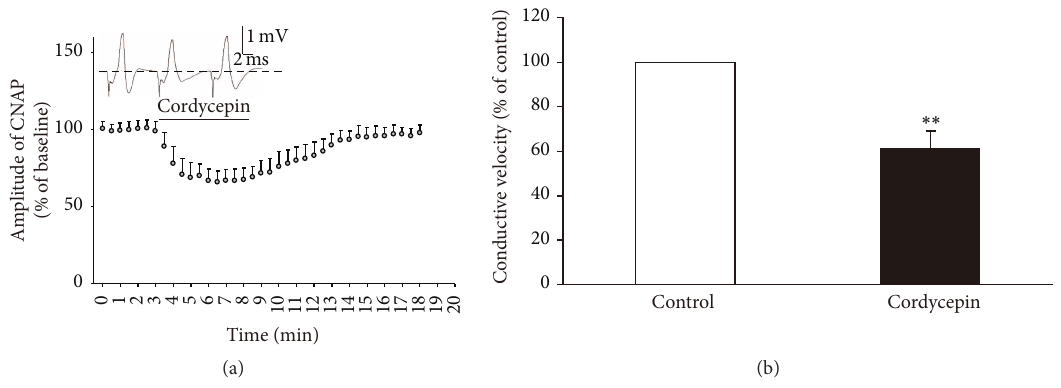
Figure 6: Effects of 50 mg/L cordycepin on amplitude and conductive velocity of compound nerve action potential (CNAP) in RS supplemented with 0.3 mM NiCl 2 . (a) Sample traces (top) show the CNAP recorded before, during, and after cordycepin. Below are the time courses of the effects of cordycepin on the amplitude of CNAP conduction. Horizontal bar indicates the bath application of cordycepin. (b) Summary of changes in conductive velocity of CNAP induced by cordycepin. The velocity of the stable state before the nerve was exposed to cordycepin is defined as the control value and scaled to 100%. ∗ 𝑃 < 0.05 , ∗∗ 𝑃 < 0.01 compared with the control